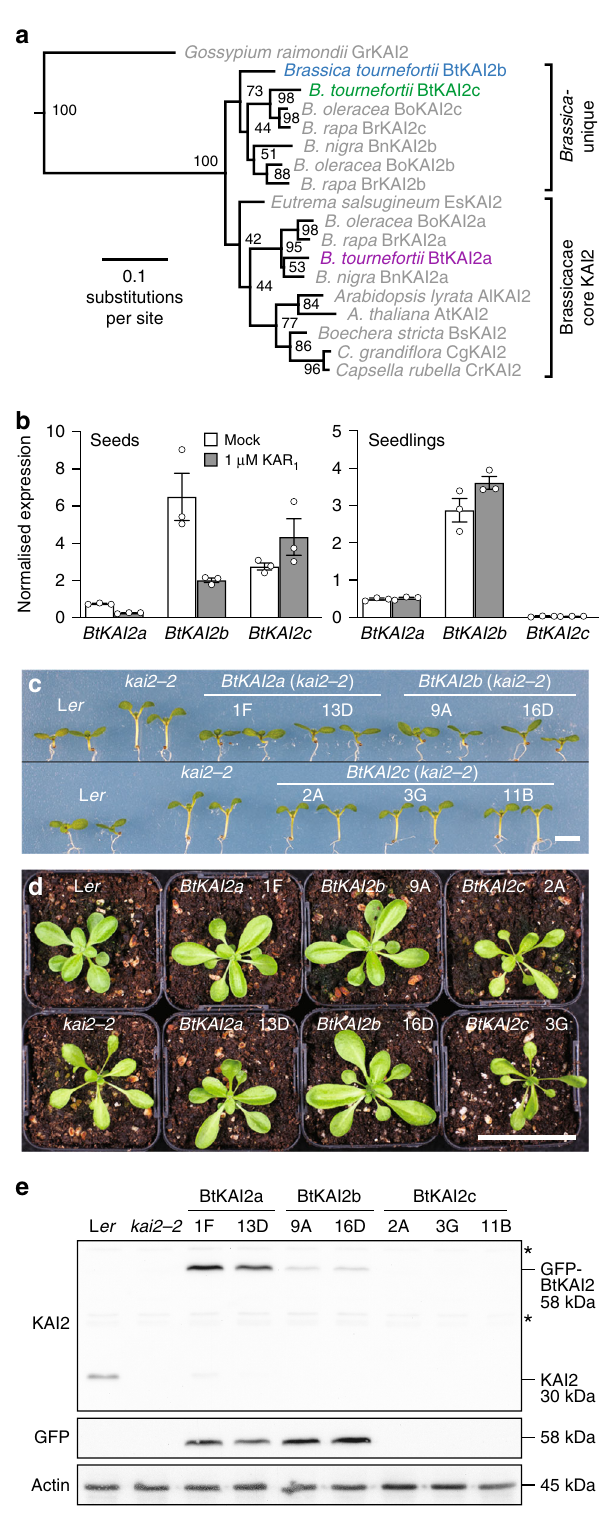
Fig. 2 Two differentially expressed B. tournefortii KAI2 homologues are functional in Arabidopsis . a Maximum likelihood phylogeny of KAI2 homologues in the Brassicaceae, based on nucleotide data. Node values represent bootstrap support from 100 replicates. A eu-KAI2 sequence from Gossypium raimondii (Malvaceae) serves as an outgroup. Tree shown is a subset of a larger phylogeny in Supplementary Fig. 2. b Transcript levels of the three BtKAI2 homologues in B. tournefortii seeds imbibed for 24 h (left) and 4-day-old seedlings (right) treated with 0.1% acetone (mock) or with 1 µ M KAR 1 for 24 h. c , d Seedling and rosette phenotypes of two independent transgenic lines of Arabidopsis homozygous for KAI2pro:GFP-BtKAI2 transgenes. Seedlings were 7 days old and rosettes 22 days old. Scale bars: 5 mm c ; 50 mm d . e Immunoblots of soluble proteins challenged with antibodies against KAI2 (upper panel), GFP (middle panel) or actin as a loading control (lower panel). Anti-KAI2 detects both the native AtKAI2 protein (30 kDa) and the GFP-BtKAI2 fusion proteins (58 kDa) but detects BtKAI2b relatively poorly. Non-speci fi c bands are marked with asterisks. Protein was isolated from pools of ∼ 50 7-day-old seedlings. Source data are provided as a Source Data fi